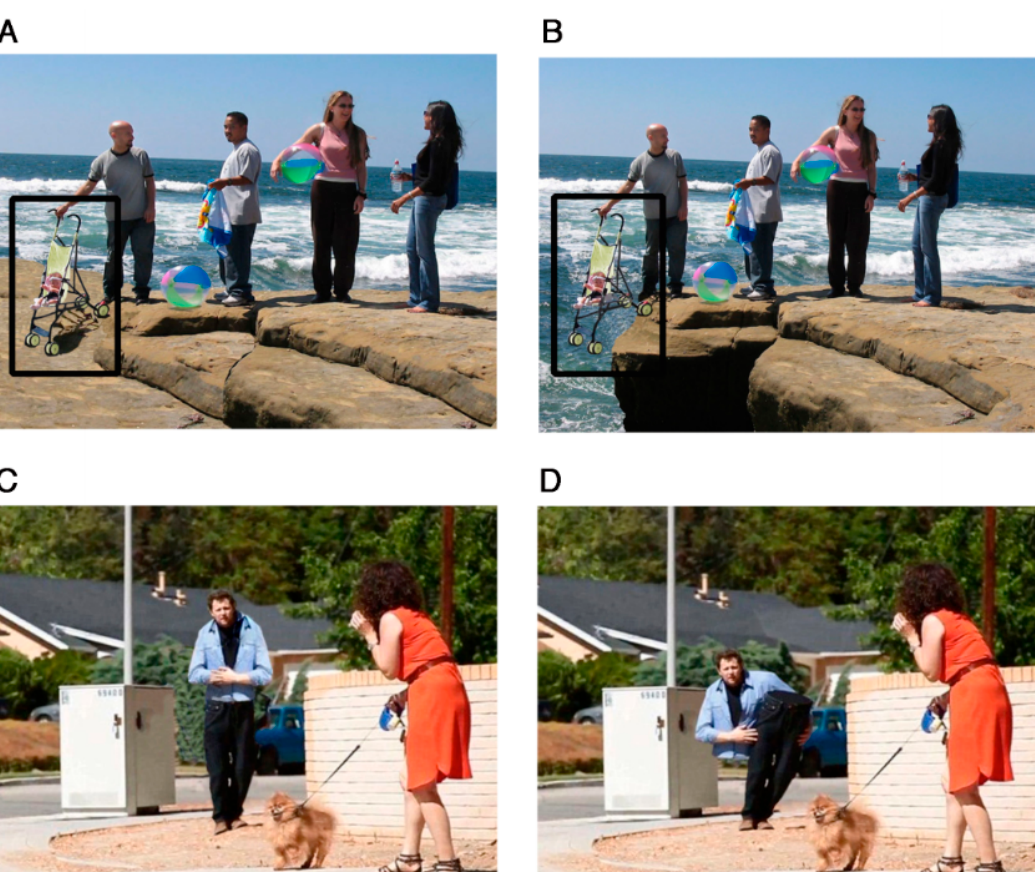
Figure 4 . Example of social normal ( A ), social weird ( B ), physical normal ( C ), and physical weird ( D ) stimuli from Benson et al.’s experiment [63]. Reproduced with permission from John Wiley and Sons. The black rectangles represent the target region and were not visible during the experiment.